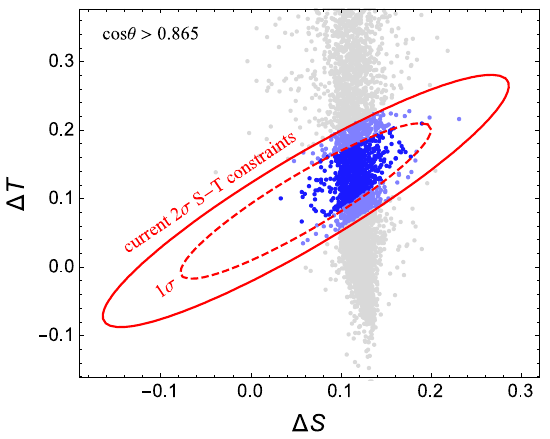
Figure 1 . Scattering plot in the S - T plane by setting the largest mass splitting between the heavier neutral(charged) fermions and the DM candidate to be 200 GeV, the dashed and solid contour is the allowed parameter space at the 68% and 95% C.L. respectively, given by the G(cid:12)tter group. their results to our B + L model, one has M =g > 6 TeV. Compared with the current B+L Z 0 LHC constraint on the Z 0 , it puts an upper bound on the g , which is about 0 : 48. B+L Once g is smaller than 0 : 48, the LHC constraint on the Z 0 will be stronger than that B+L of